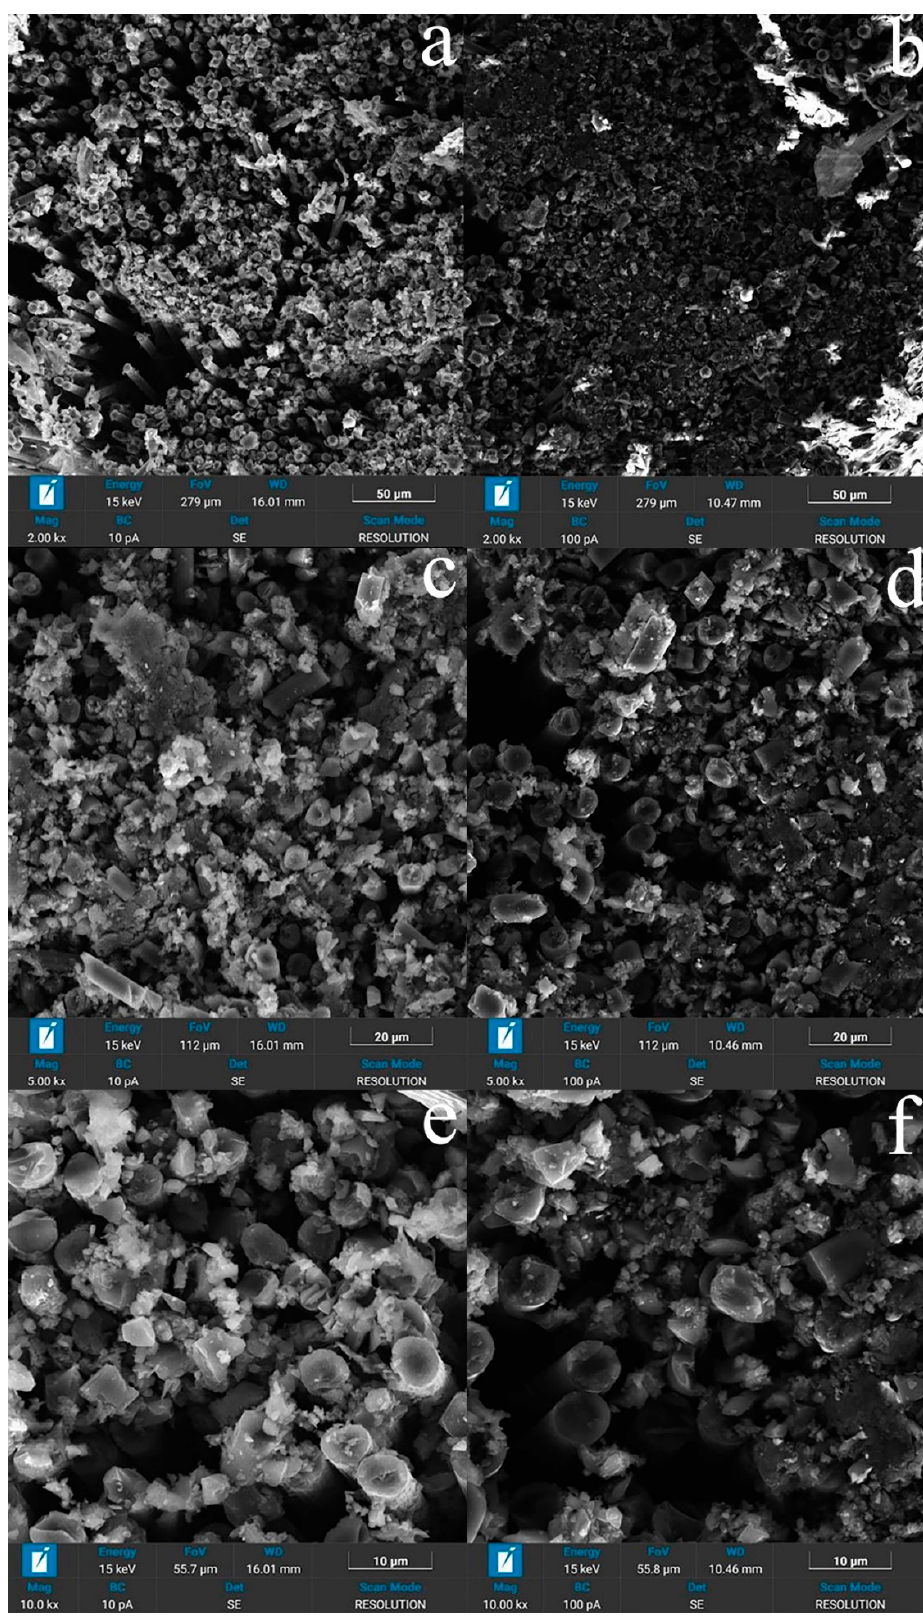
Figure 8. Surface destruction of the microcomposite CF–PSU. ( a , c , e ) Toray T700 high-strength fiber ( b , d , f ) UMT400 high-modulus fiber.